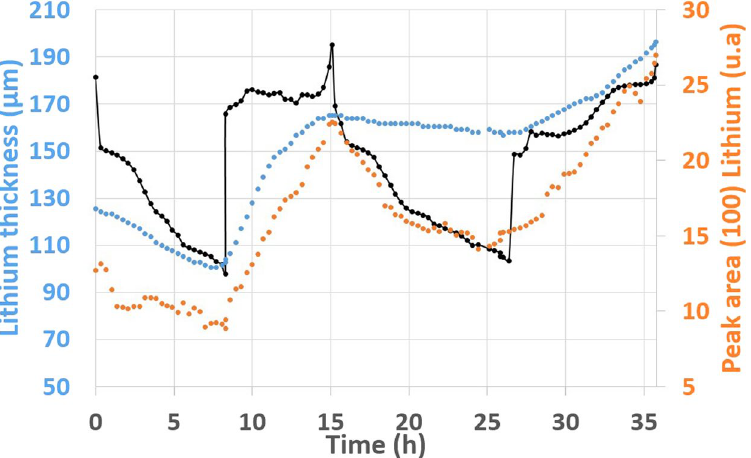
Figure 4. Comparison between tomography and XRD lithium analysis with the associated voltage profile. Lithium thickness was calculated from the tomographic images by counting the number of pixels. Lithium peak area was integrated from XRD pattern at each